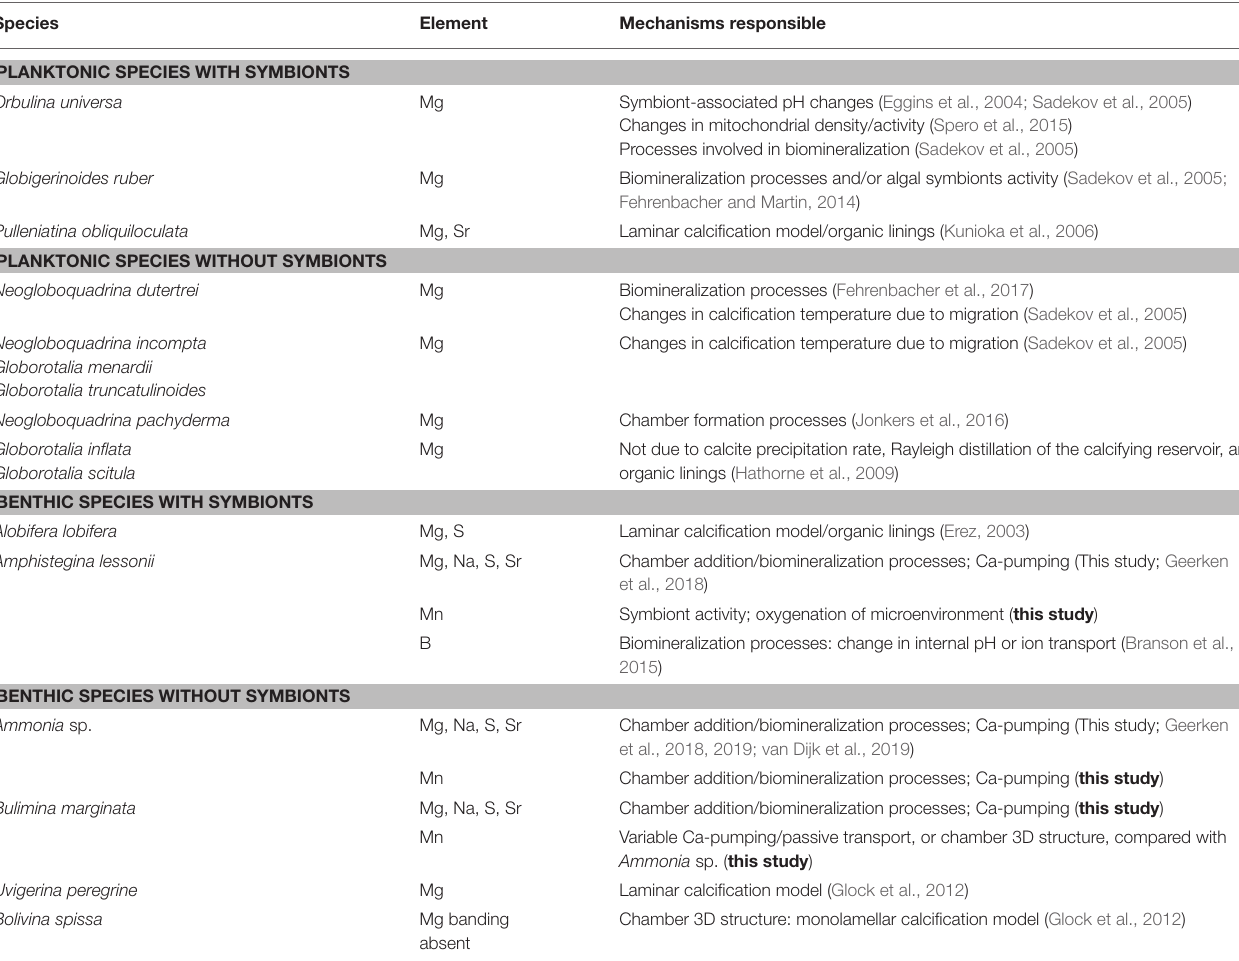
TABLE 7 | Overview of planktonic and benthic species with heterogeneous element distribution in the chamber wall, including proposed mechanisms responsible for banding.